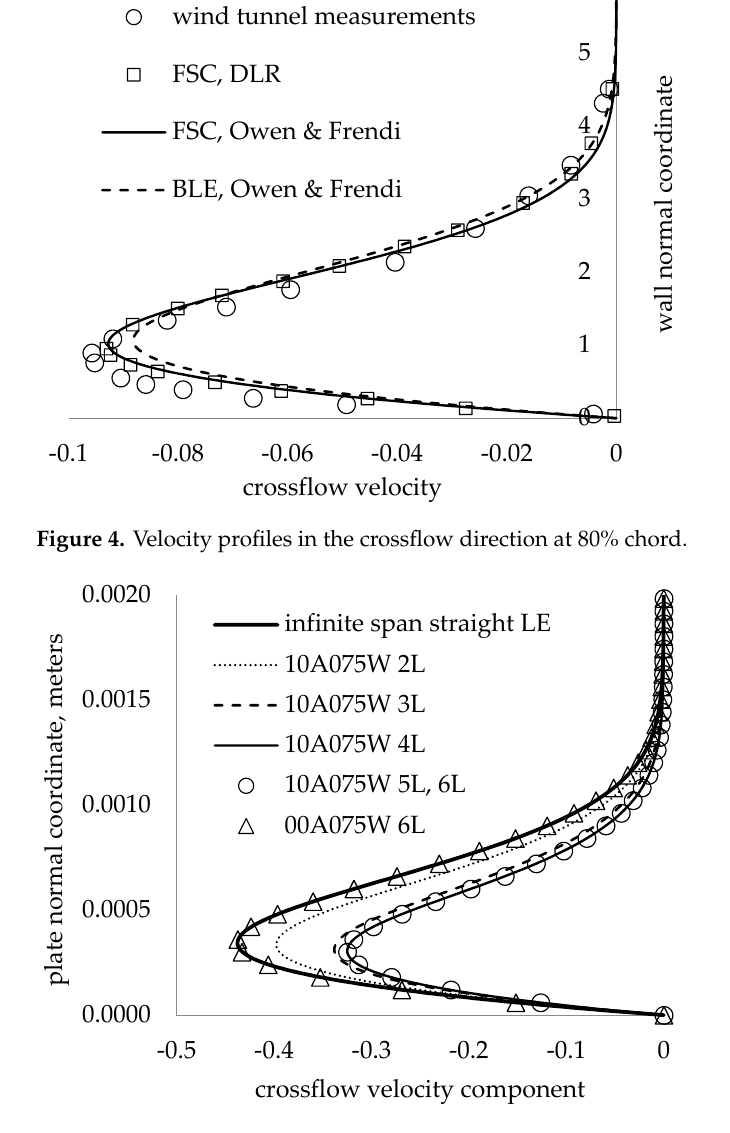
Figure 5. Crossflow velocity profiles for straight LE and 10A075W LE at different span locations, at 20% chord.